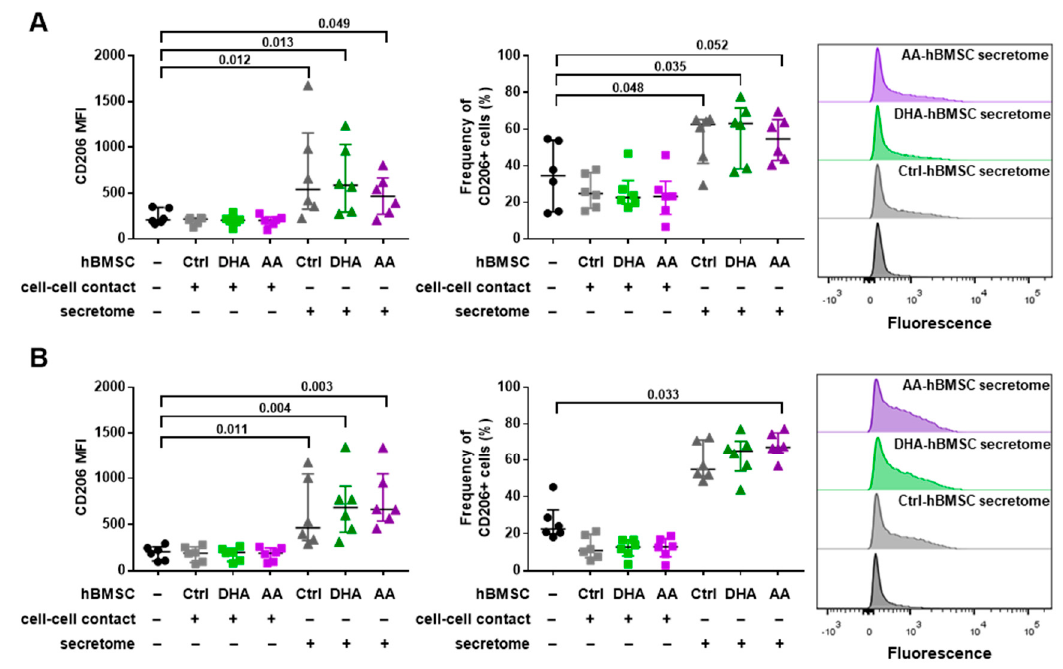
Figure 4. The secretome of hBMSCs increases the expression of CD206. ( A ) The upper panel describes the results of Mreg-polarized macrophages and ( B ) the lower panel the results of Mreg-activated macrophages. The median fluorescence intensities (MFI, left panel) and frequencies of positive cells (middle panel) were determined with flow cytometry. The representative histograms are presented on the right. The differences among groups were determined with Kruskal-Wallis rank sum test and post hoc using Dunn’s test. These results are also described as log2 fold changes in Figures 2 and 3. The results are expressed as medians with interquartile ranges; n = 6 biological replicates. Ctrl, control; DHA, docosahexaenoic acid; AA, arachidonic acid.